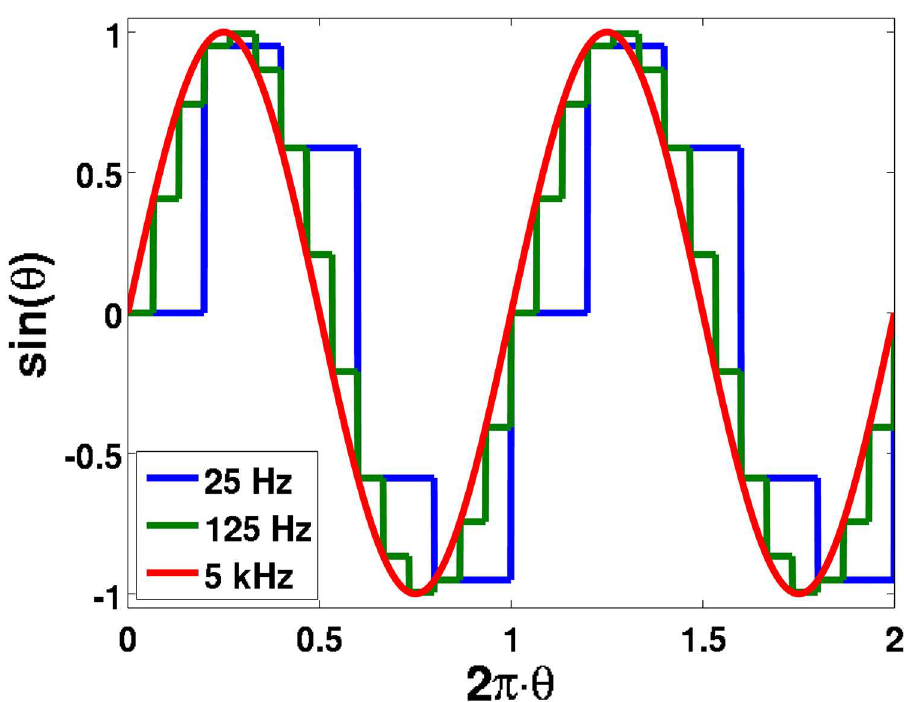
Fig 1. The sinosoidal function simulated for the output of a 25 Hz, 75 Hz, and 5 kHz PWM function, all with a 200 μ s time-step.